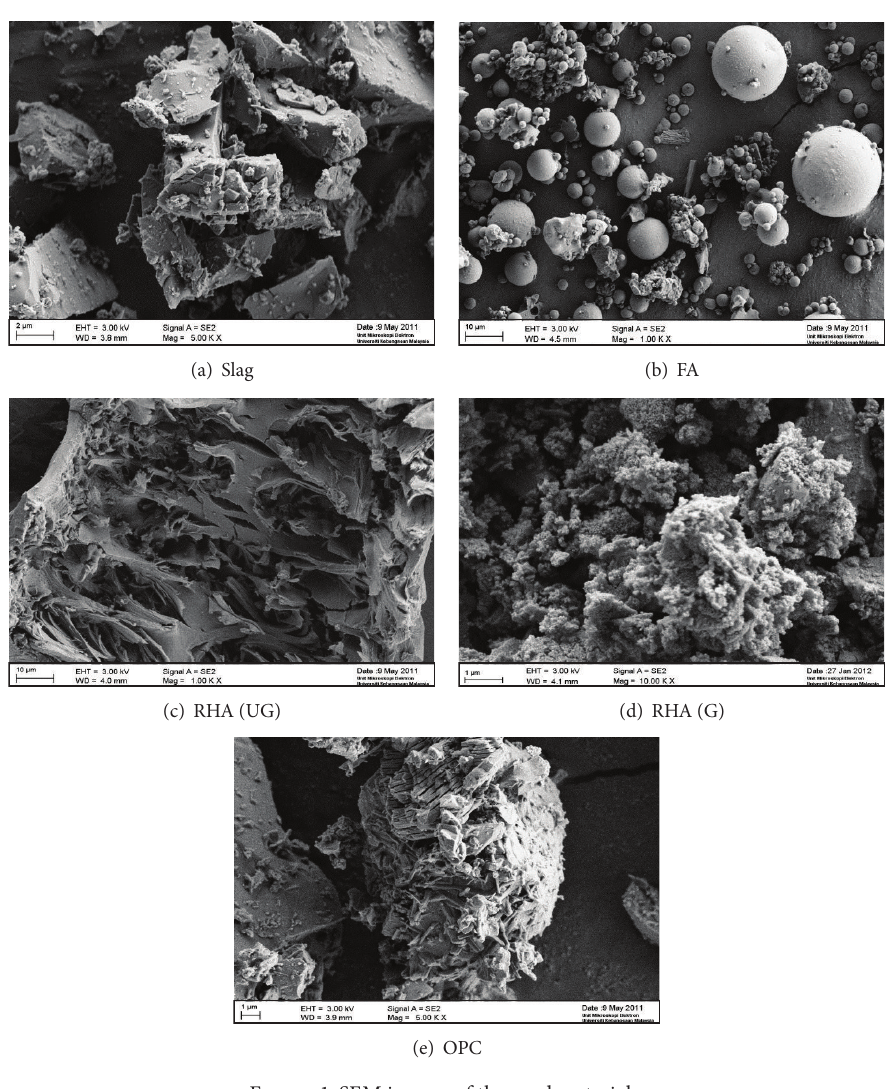
Figure 1: SEM images of the used materials.